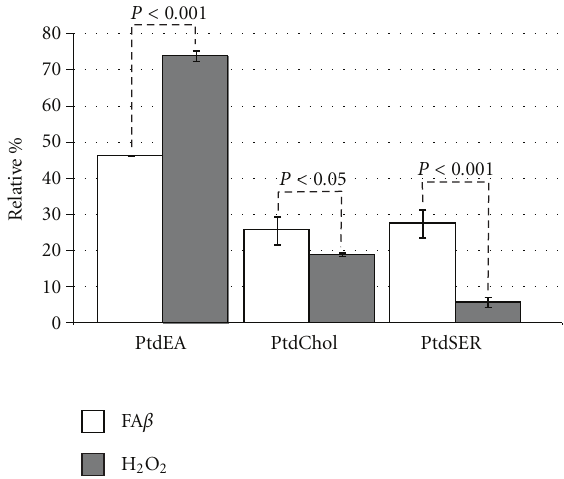
Figure 10: Significant di ff erences between A β -injected brains and H 2 O 2 -injected